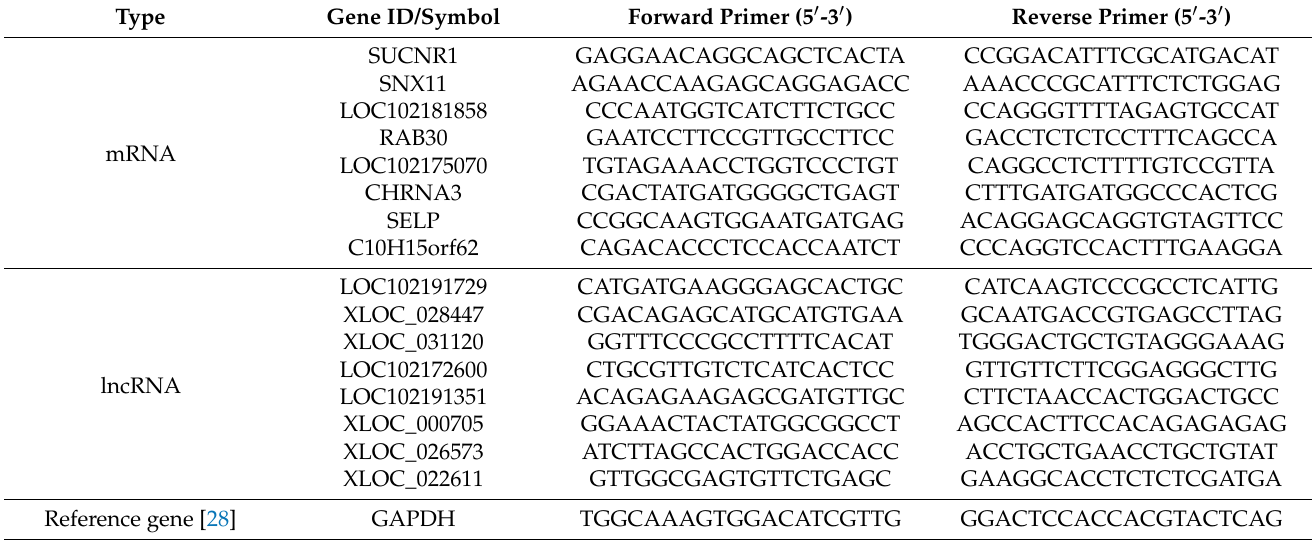
Table 2. Sequence information of